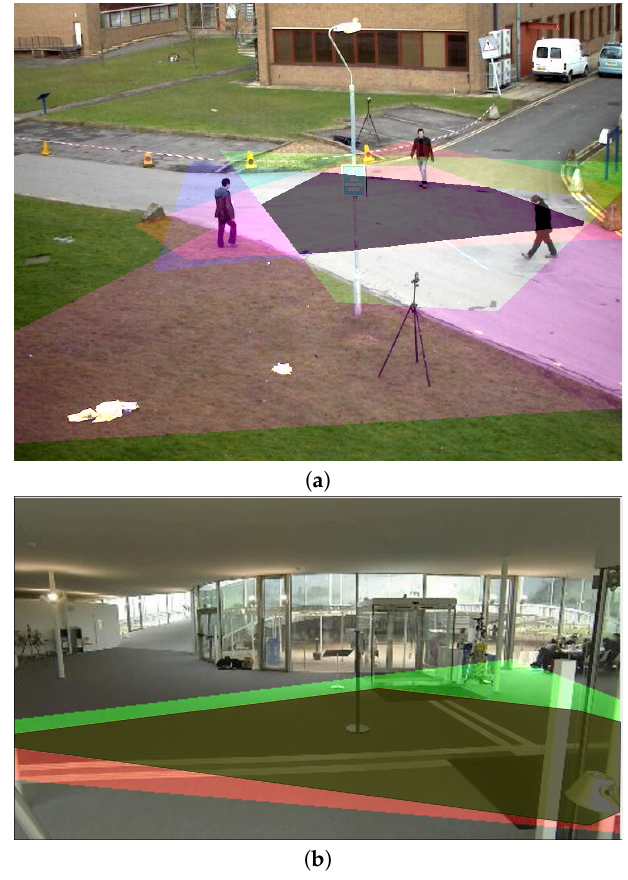
Figure 4. PETS2009 ( a ) and EPFL-RLC ( b ) view planes of each camera (five and three cameras, respectively) and the common field of view of all